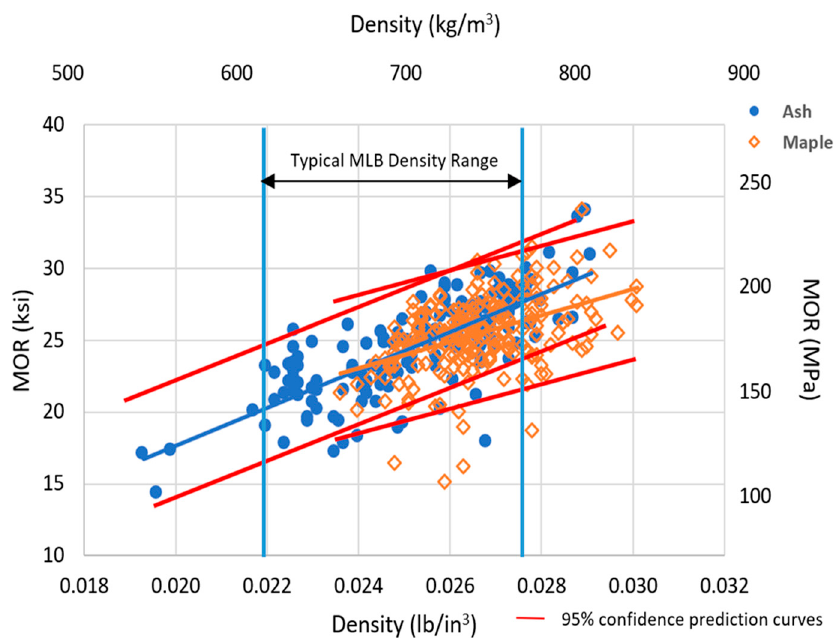
Figure 2. Modulus of Rupture (MOR) test results for ash and maple dowels with slope-of-grain angles spanning the range of ±3°.